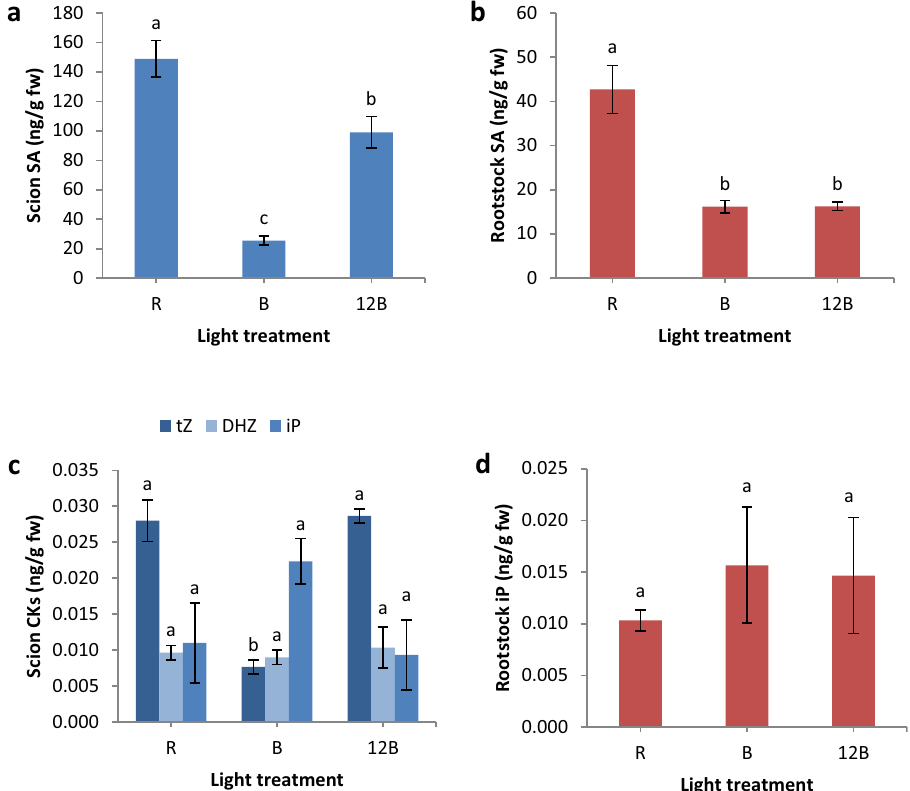
Figure 5. Salicylic acid (SA) ( a , b ) and cytokinins (CKs) trans-zeatin (tZ), dihydrozeatin (DHZ) ( c ), and isopentenyladenine (iP) ( c , d ) of scion ( a , c ) and rootstock ( b , d ) segments of grafted watermelon seedlings under three light treatments in the healing chamber at three days after grafting. Bars (± SE) followed by different letters are significantly different (a < 0.05). Mean values derived from n = 3 seedlings.